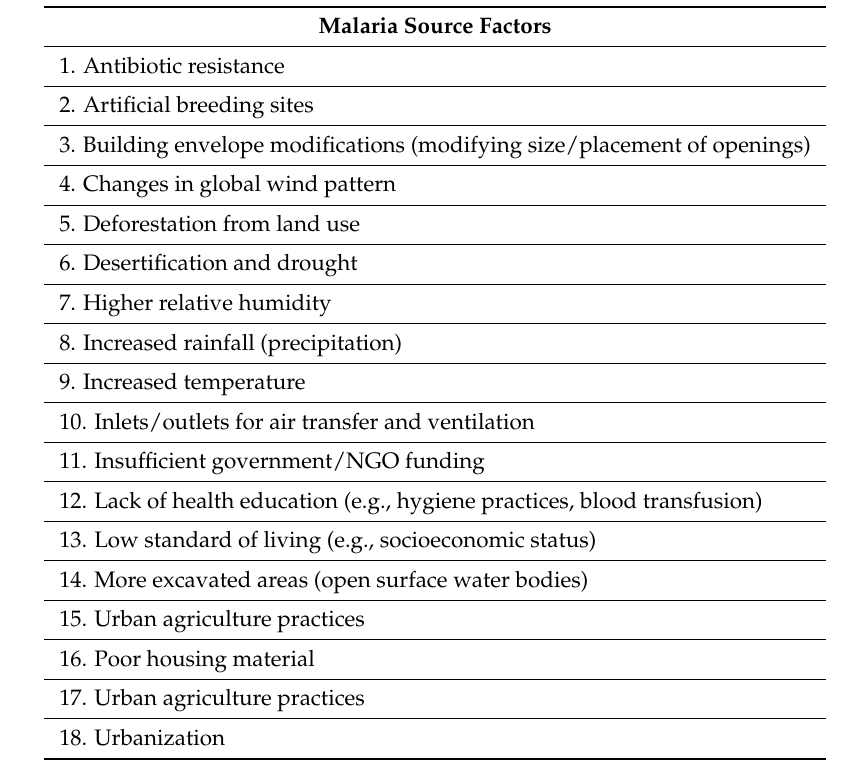
Table 4. List of categorized source factors (Step 2).